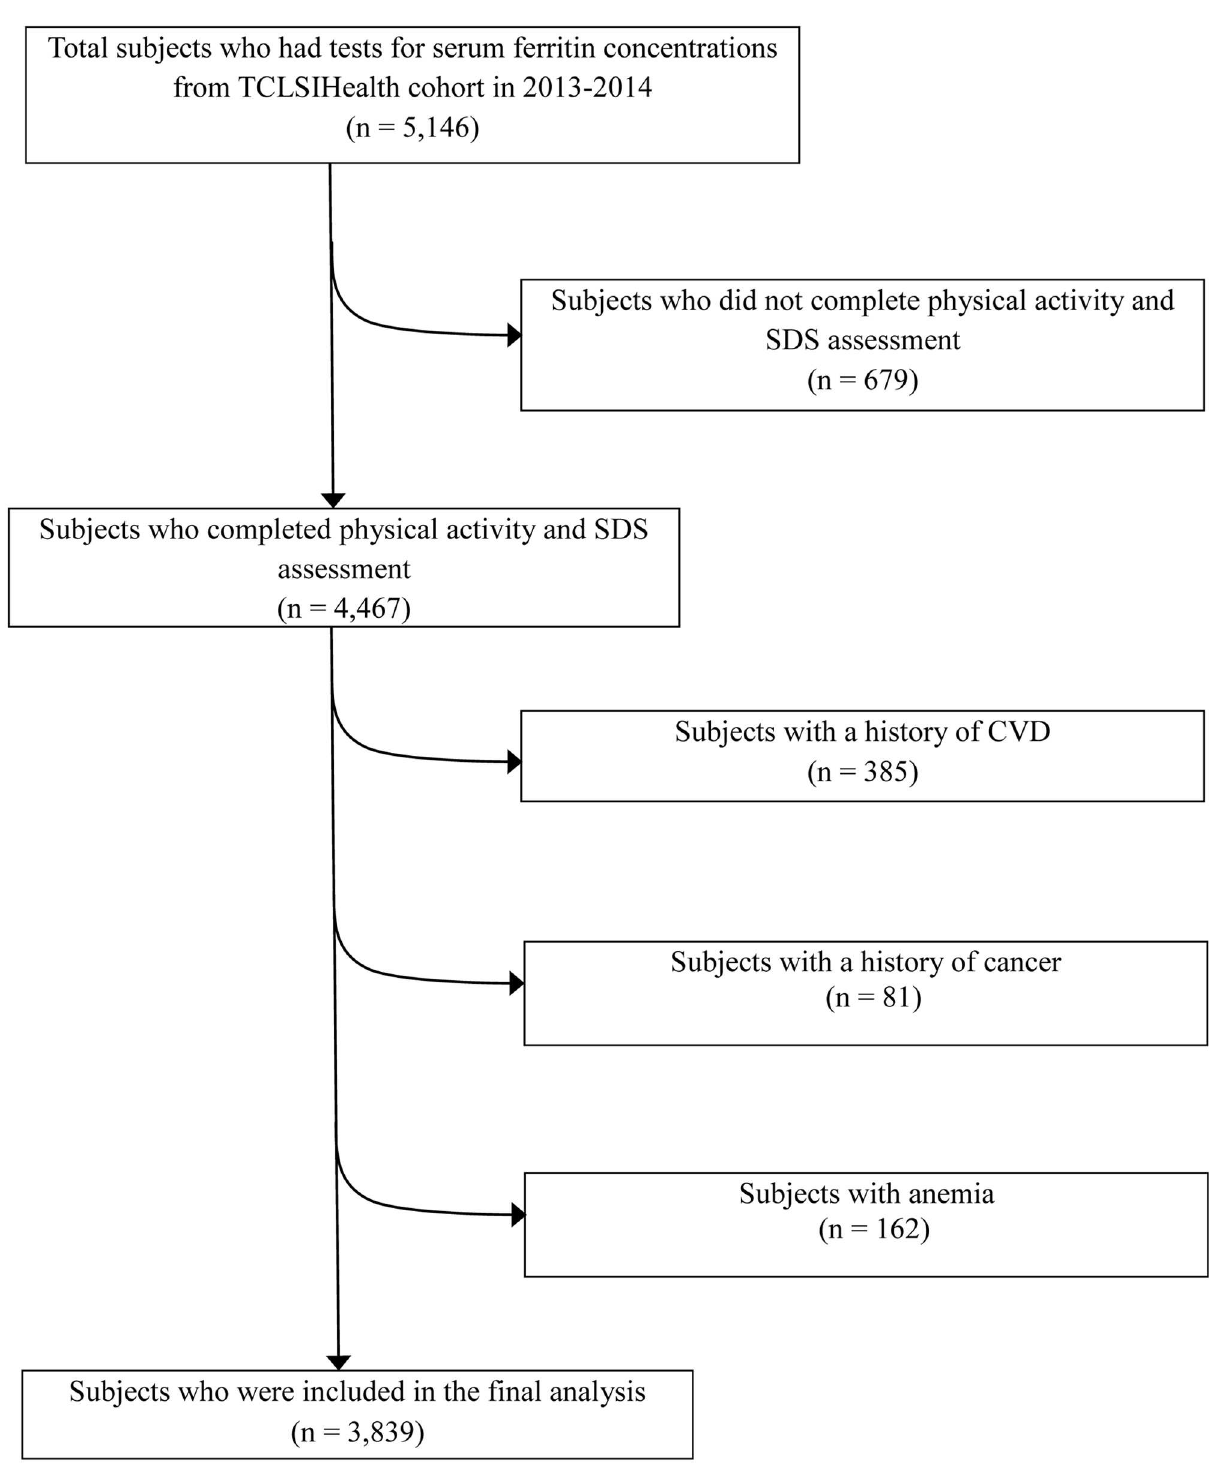
Fig 1. Flow chartof the sampleselection. TCLSIHealth cohort:the TianjinChronicLow-grade SystemicInflammation and Healthcohort; SDS: the Zung Self-Rating Depression Scale; CVD: cardiovascular disease.